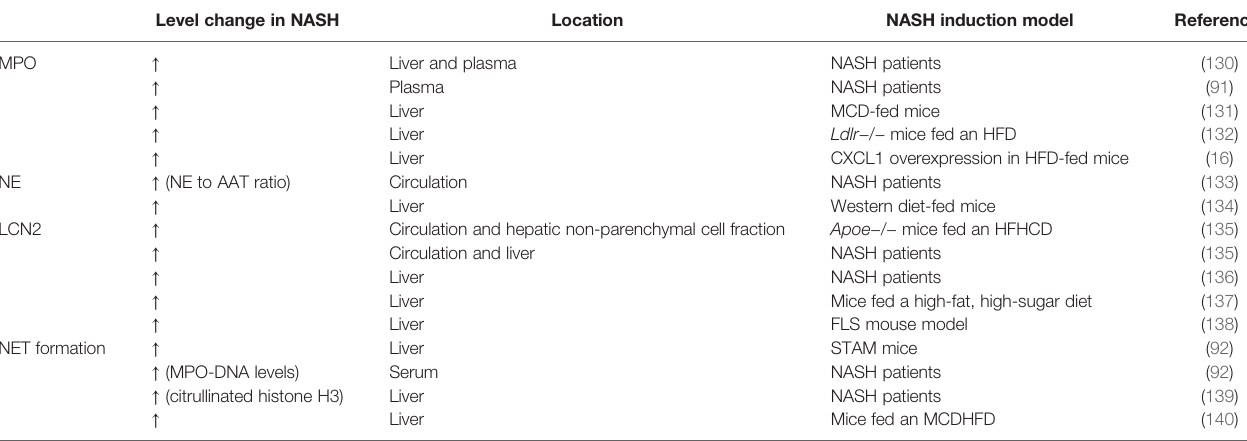
TABLE 2 | Elevation of neutrophil-related factors in NASH patients and experimental NASH models.